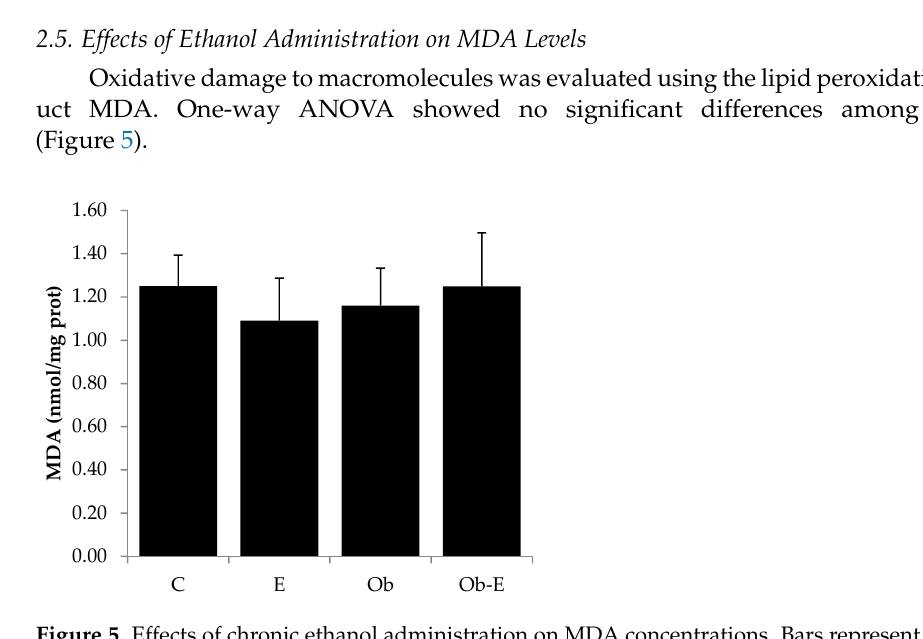
Figure 5. Effects of chronic ethanol administration on MDA concentrations. Bars represent the mean ± SEM. C, wild-type control; E, wild-type ethanol; Ob, Ob control; Ob-E, Ob–ethanol.